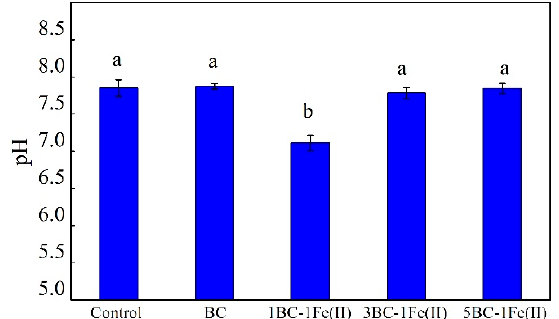
Figure 2. The pH in di ff erent treatments. Lowercase letters indicate significant di ff erences ( p < 0.05). BC, applied 1% biochar; 1BC-1Fe(II), applied 0.5% biochar and 0.5% ferrous sulfate; 3BC-1Fe(II), applied 0.75% biochar and 0.25% ferrous sulfate; 5BC-1Fe(II), applied 0.83% biochar and 0.17% ferrous